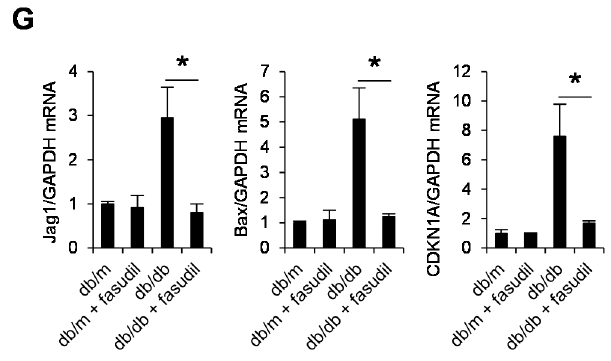
Figure 4. Treatment of db / db mice with fasudil prevents podocyte loss. ( A ) A representative blot of three independent experiments and quantitative analyses of the phosphorylated form of myosin phosphatase target subunit 1 (MYPT1) (p-MYPT1) and MYPT1 in protein extracts from the renal cortex of db / m mice, db / m mice given fasudil ( db / m + fasudil), db / db mice, and fasudil-treated db / db mice ( db / db + fasudil); ( B ) Representative photomicrographs of periodic acid-Schiff (PAS) and WT1-stained kidney sections. Original magnification, × 400; Quantitative analyses of WT1-positive cells in ( C ) the glomerulus and the urinary excretion of nephrin; ( D – F ) TUNEL-stained glomerular cells and changes in the albumin excretion in each group; ( G ) Jag1 and apoptotic markers were analyzed in the isolated podocytes. * p < 0.05. The data are presented as the means ± SD. ( n = 5 in each group).